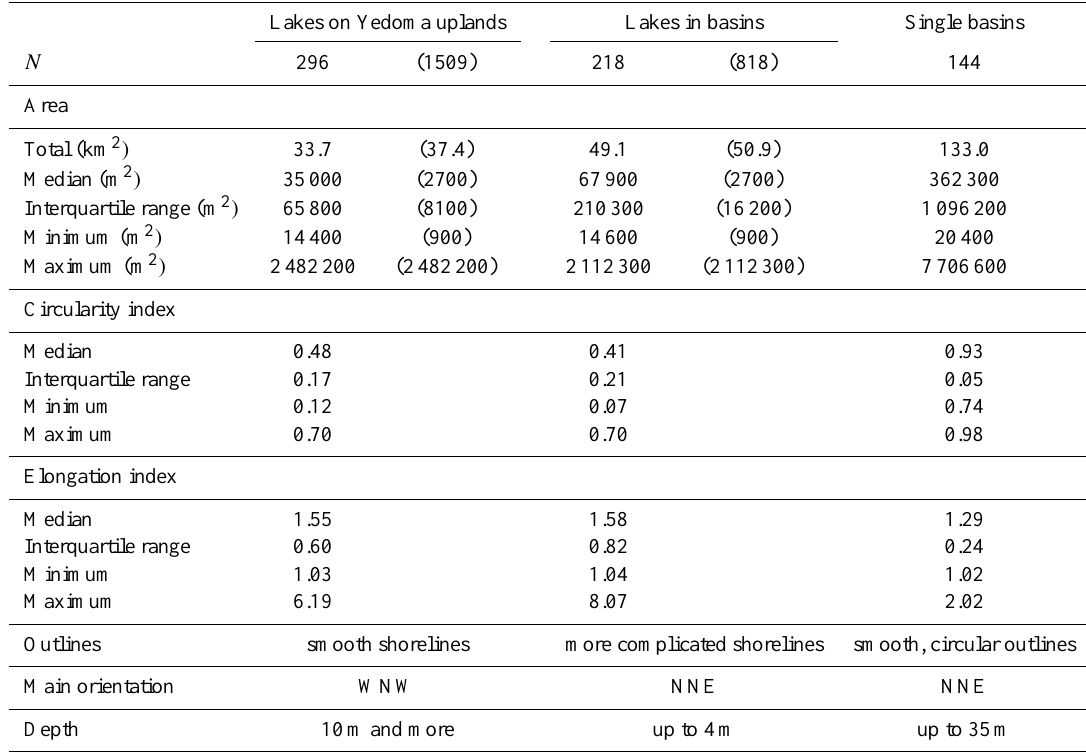
Table 5. Comparison of morphometric characteristics of thermokarst lakes ≥ 14400m 2 and single basins. Area values for all lakes including lakes < 14400m 2 are shown in brackets.